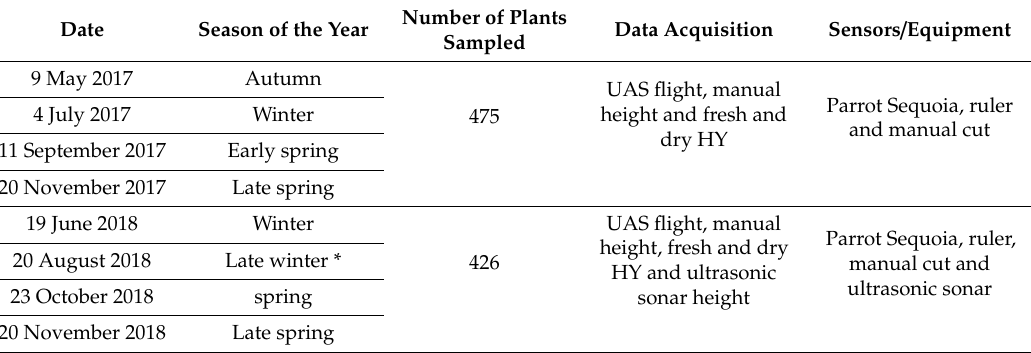
Table 1. Overview of the data collected from individual plants, data collection date, sensors applied and equipment used for measurements.